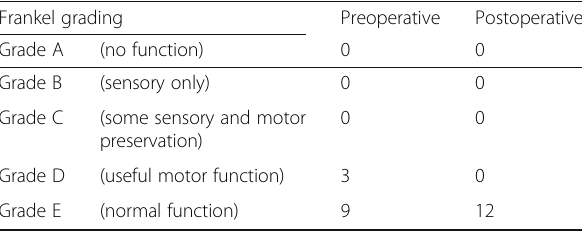
Table 4 Improvement in neurological condition using the Frankel grading system